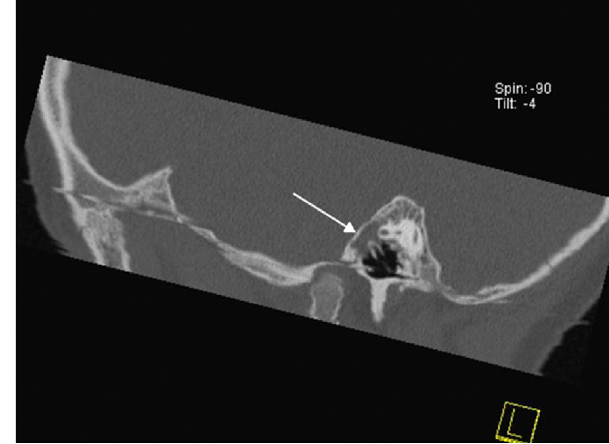
Coronal MDCT scan of the left temporal bone show- ing aerated mesotympanum and the soft tissue mass around malleus head and incus body (arrow).